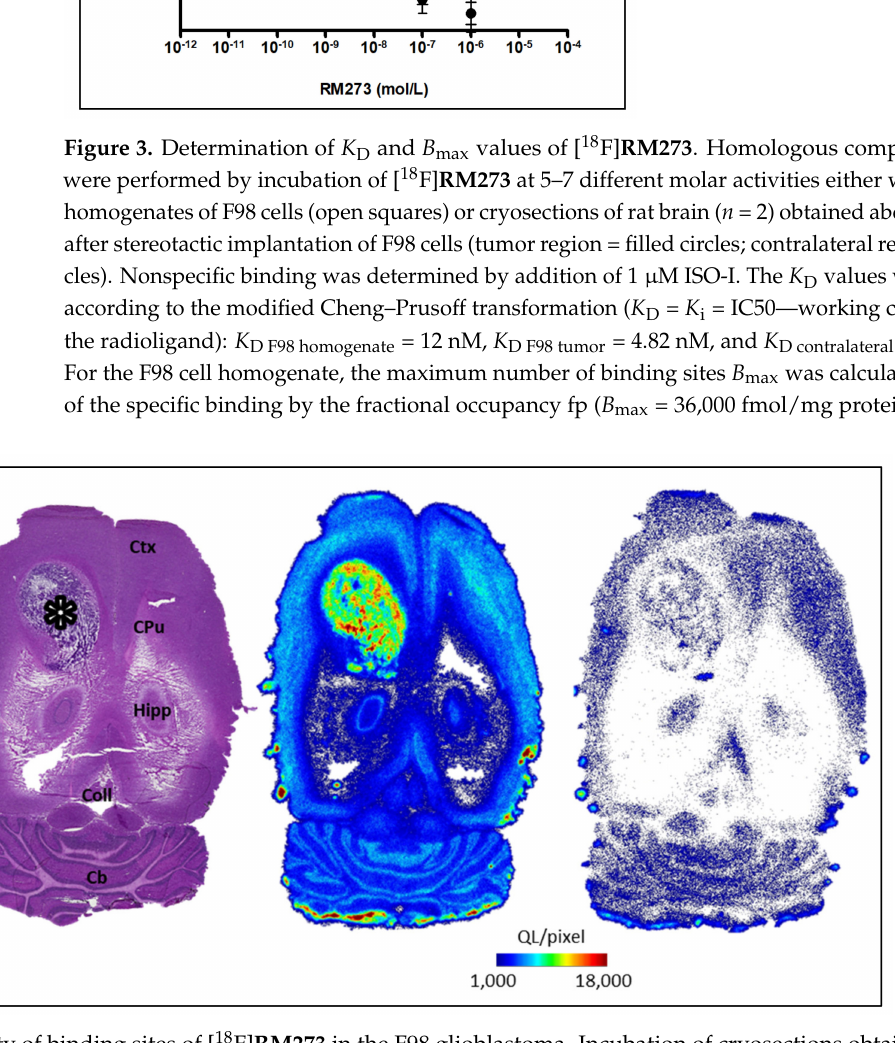
Figure 4. High density of binding sites of [ 18 F] RM273 in the F98 glioblastoma. Incubation of cryosections obtained from rat brain about three weeks after stereotactic implantation of F98 cells in the striatum with 1.5 nM [ 18 F] RM273 without (total binding; middle) or with co-incubation with 1 µ M ISO-I (nonspecific binding; right). A remarkably high density of binding sites is detectable in the tumor region (asterisk). The complete displacement of activity also in the tumor region indicates the identity of these binding sites with σ 2 receptors. For anatomic correlation, Nissl staining was performed (left). Abbreviations: Cb = Cerebellum, Coll = Colliculi, CPu = Caudate putamen, Ctx = Cortex, Hipp =